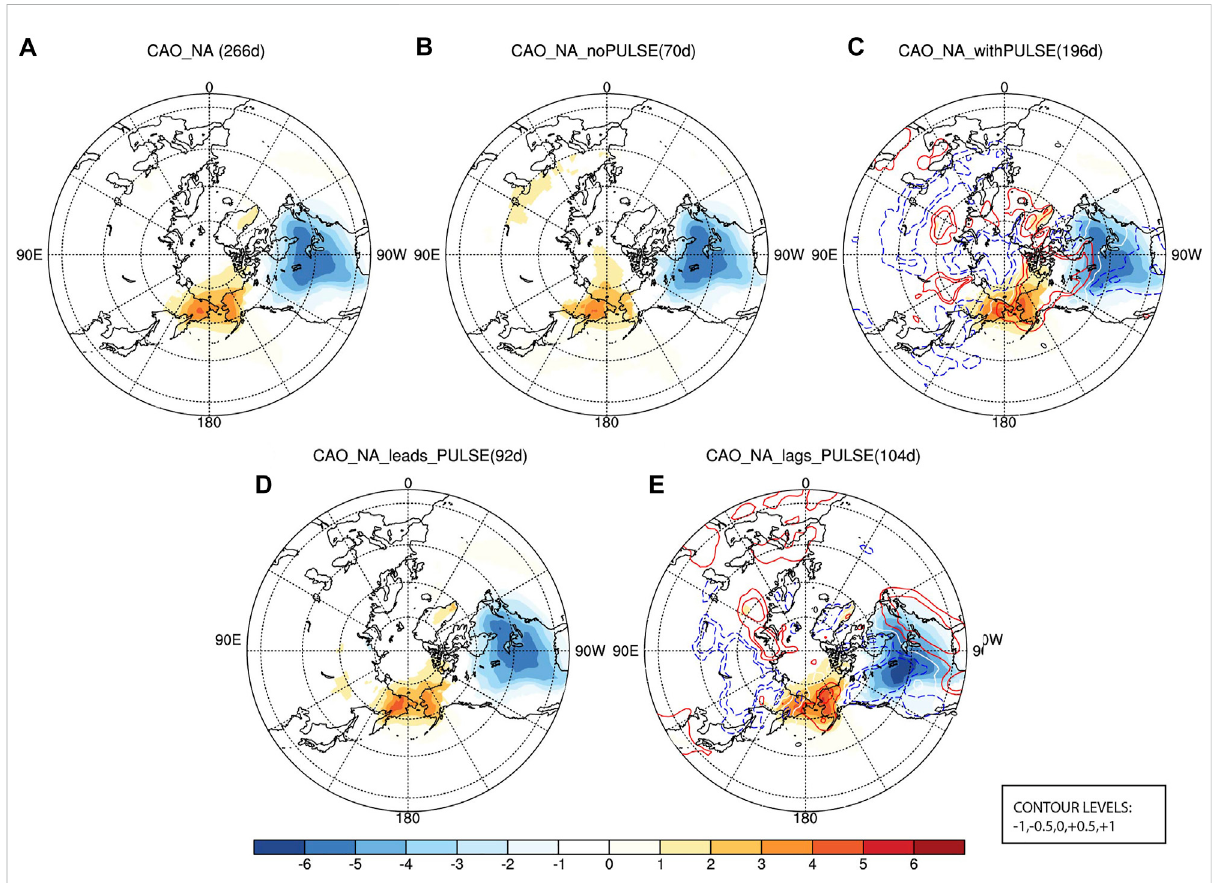
FIGURE 1 Compositemeanmapsofsurfaceairtemperature(SAT)anomaliesduringCAO_NAeventsinwinters(November – March)from1979to2015. (A) AllCAOs;CAOsthatare (B) decoupledfromand (C) coupledwithstratosphericPULSE events;andCAOsthatarecoupledwithPULSEsandoccurred withintheweek,respectively, (D) beforeand (E) afterthepeakdatesofPULSEs.Onlythecompositesabovethe95%con fi dencelevelusingtwo-sided Student ’ s t test are shown. Contours in panel (C) denote the SAT anomaly difference between (C,B) , and contours in panel (E) denote the SAT anomaly difference between (E,D)